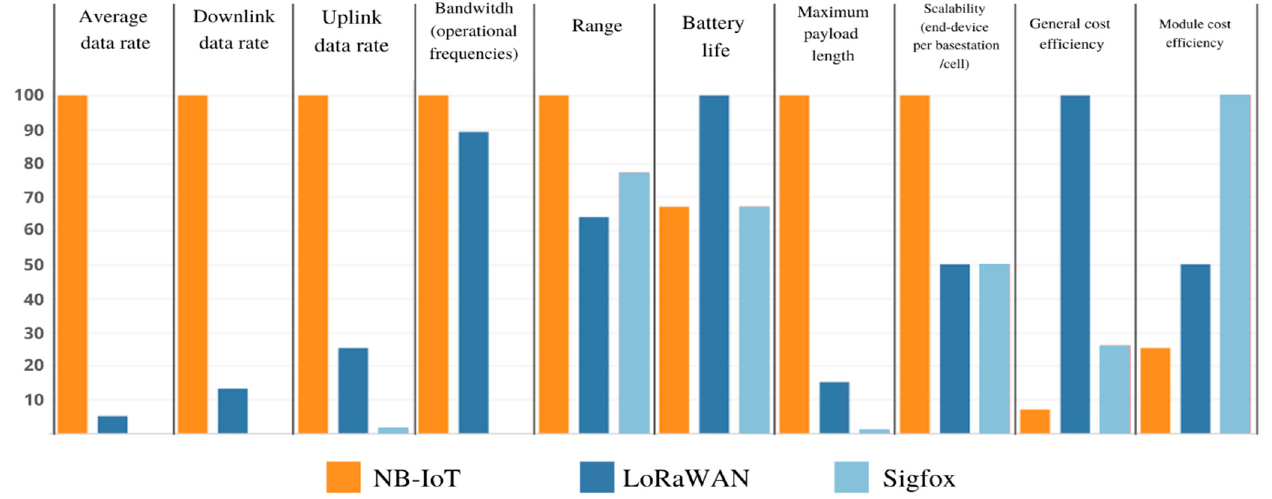
Figure 3. A respective view of the characteristics of Sigfox, NB-IoT, and LoRaWAN across a scale of 0 to 100.